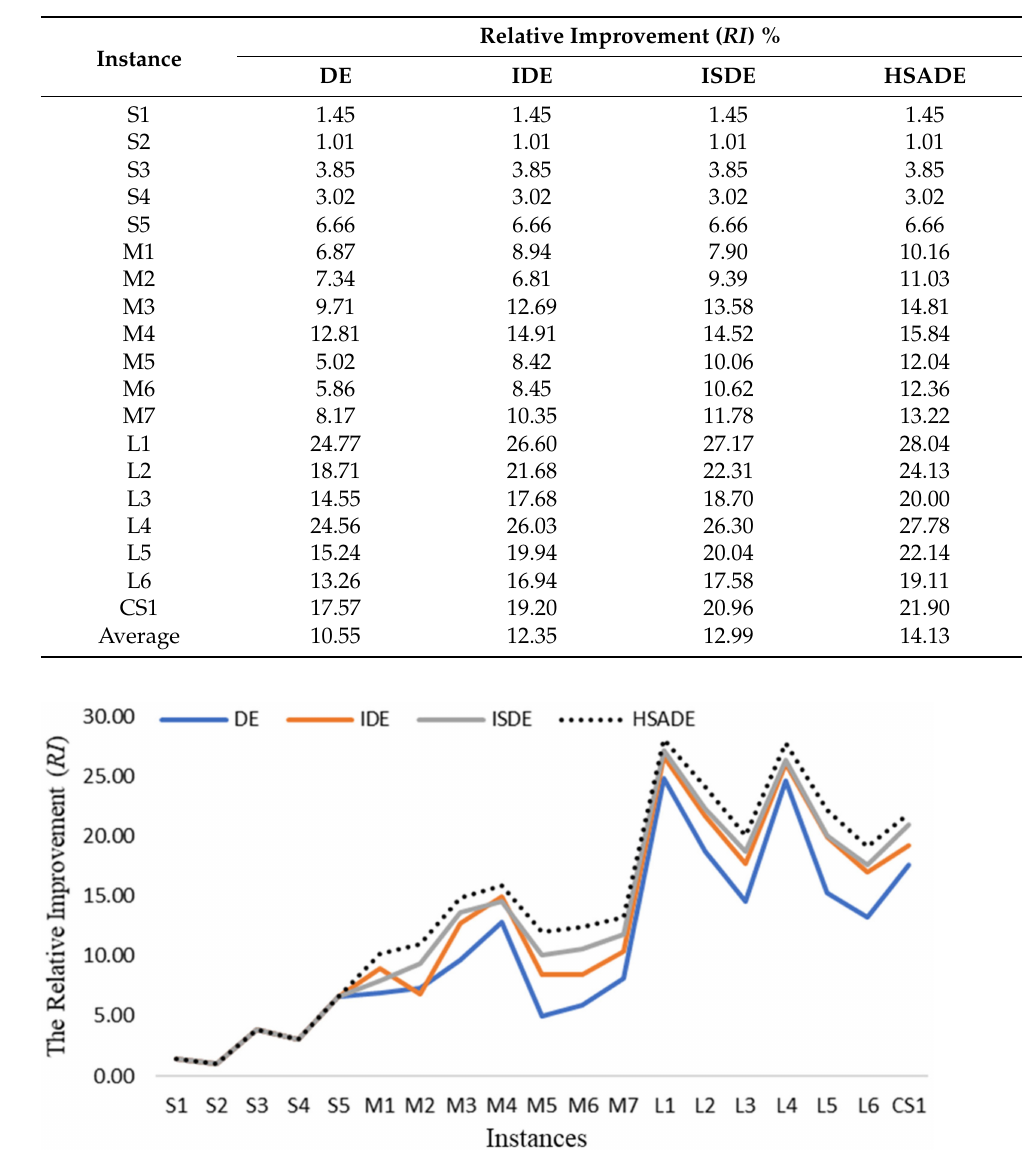
Table 7. The relative improvement ( RI ) results for testing instances.